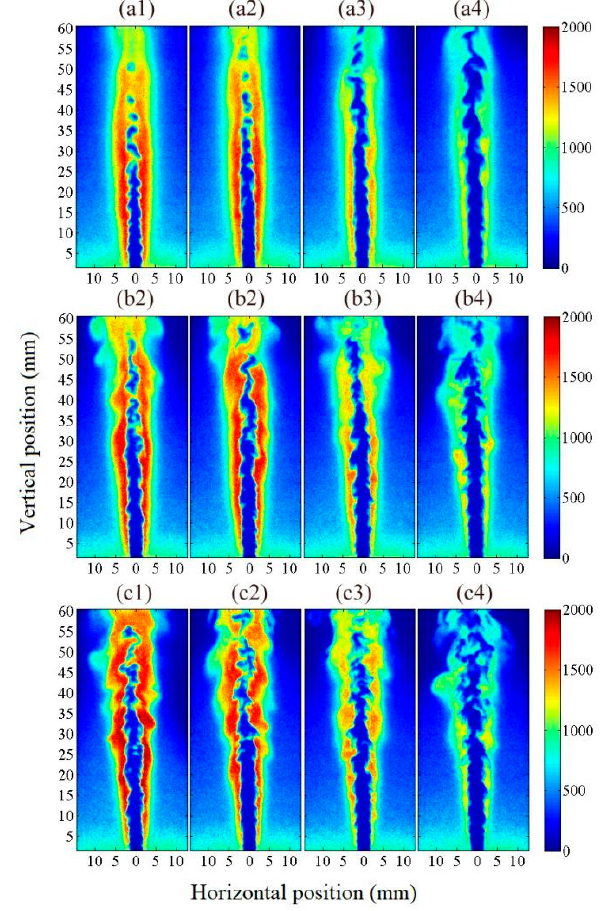
Figure 5. OH distribution instantaneous image of syngas with volumetric ratio of 5%H 2 –95%CO under different dilutions and Reynolds numbers: ( a1 – a4 ) Re = 6110; ( b1 – b4 ) Re = 10,690; ( c1 – c4 ) Re = 15,270. 1,2,3, and 4 indicate nitrogen dilution volumetric proportions of 0%, 10%, 30%, and 50%, respectively.